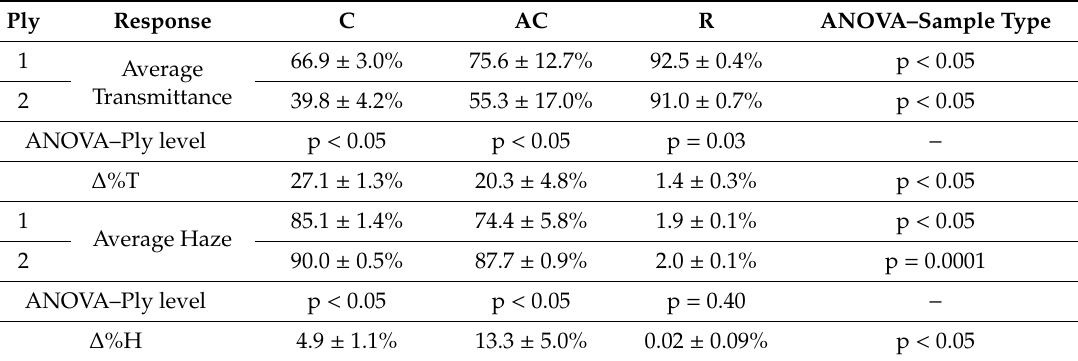
Figure 3. ( a ) Visible light transmittance and ( b ) haze for 1-ply (solid trace) and 2-ply (dashed trace) TWC composites and resin. Table 2. Transmittance and haze responses with ANOVA results.